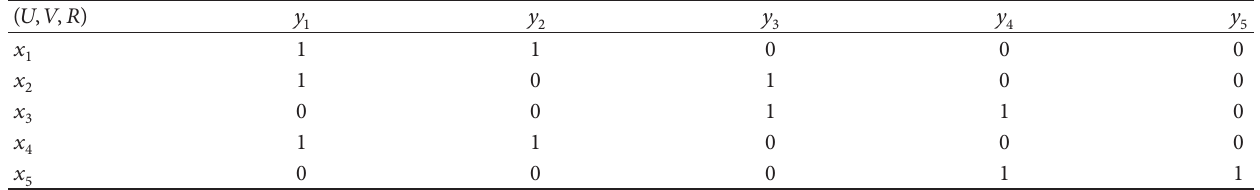
Table 2: The relations between symptoms and